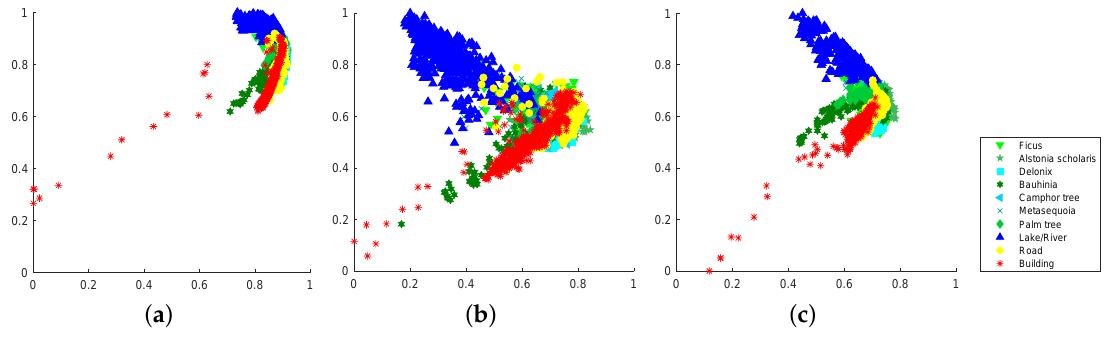
Figure 12. Scattering map of the two-dimensional features obtained by the discriminator of ( a ) GAN-or, ( b ) GAN-dw and ( c )